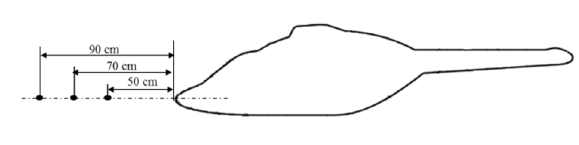
Fig. 12. Locations of the CTA